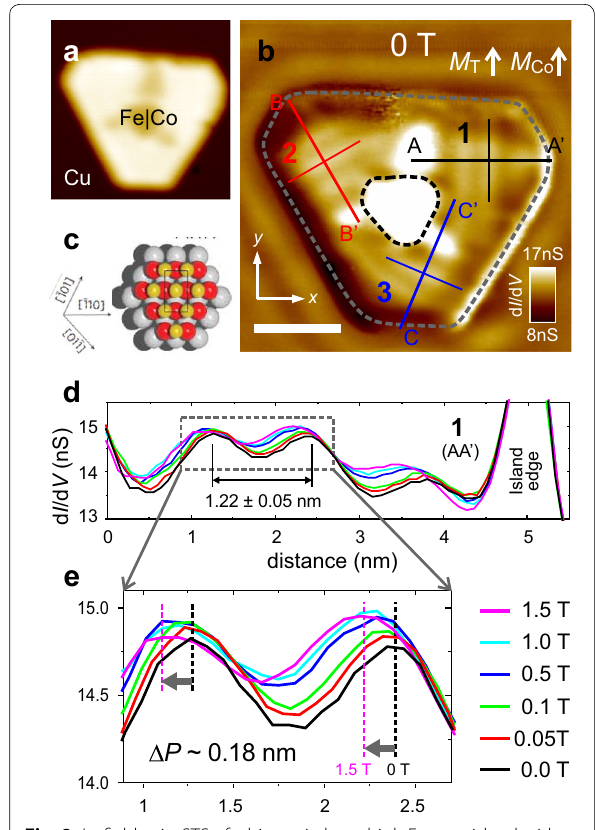
Fig. 8 In‑field spin‑STS of a biatomic‑layer‑high Fe nanoisland with a Stoner‑Wohlfarth tip. a CC‑STM image of a Fe|Co island on Cu(111). Scale bar is 4 nm long. b Hard sphere model of the atomic stacking in a Fe|Co island. The gray , red , and yellow spheres are the Cu, bottom layer Fe, and top layer Fe, respectively. c d I /d V map of the Fe|Co island shown in a measured at 0 T, where both magnetizations of tip M T and Co core M Co point up ( V b 0.3 V, I set 3 nA). The island edges and = − = Co core are indicated by the grey and black dashed lines . The stripe patterns in three ( 1 , 2 , 3 ) regions originate from the non‑collinear cycloidal spin orders in the bridge‑stacked bilayer Fe on Cu(111). The black , red and blue solid lines ( arrows ) indicate the directions of the stripes (wave vectors of the cycloidal spin orders), in the regions 1 , 2 and 3 , respectively. d Field‑dependence of d I /d V profiles along the arrow 1 in a, measured with the field sweep of 0–1.5 T. e Magnified view of the grey dashed box in d and is shown for a clarity of field‑ dependent shifts of the location of the maxima in d . The black and purple dotted lines denote the peak positions of the profiles measured at 0 and 1.5 T, respectively (Reprinted from [7] with permission